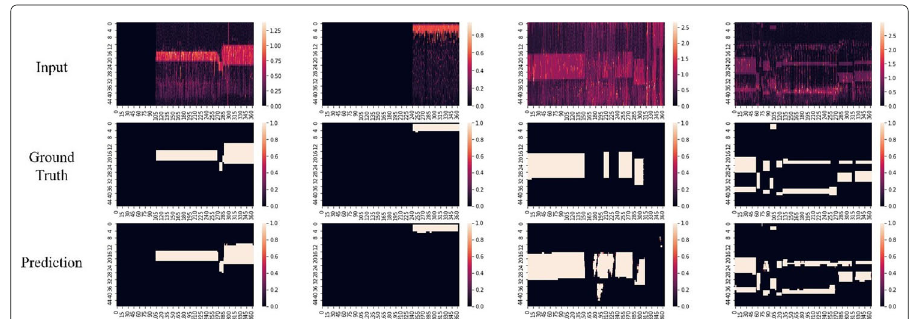
Fig. 4 Train step vs train loss. With learning rate 0.0001, decay rate 0.96, batch size 20, total steps 1000